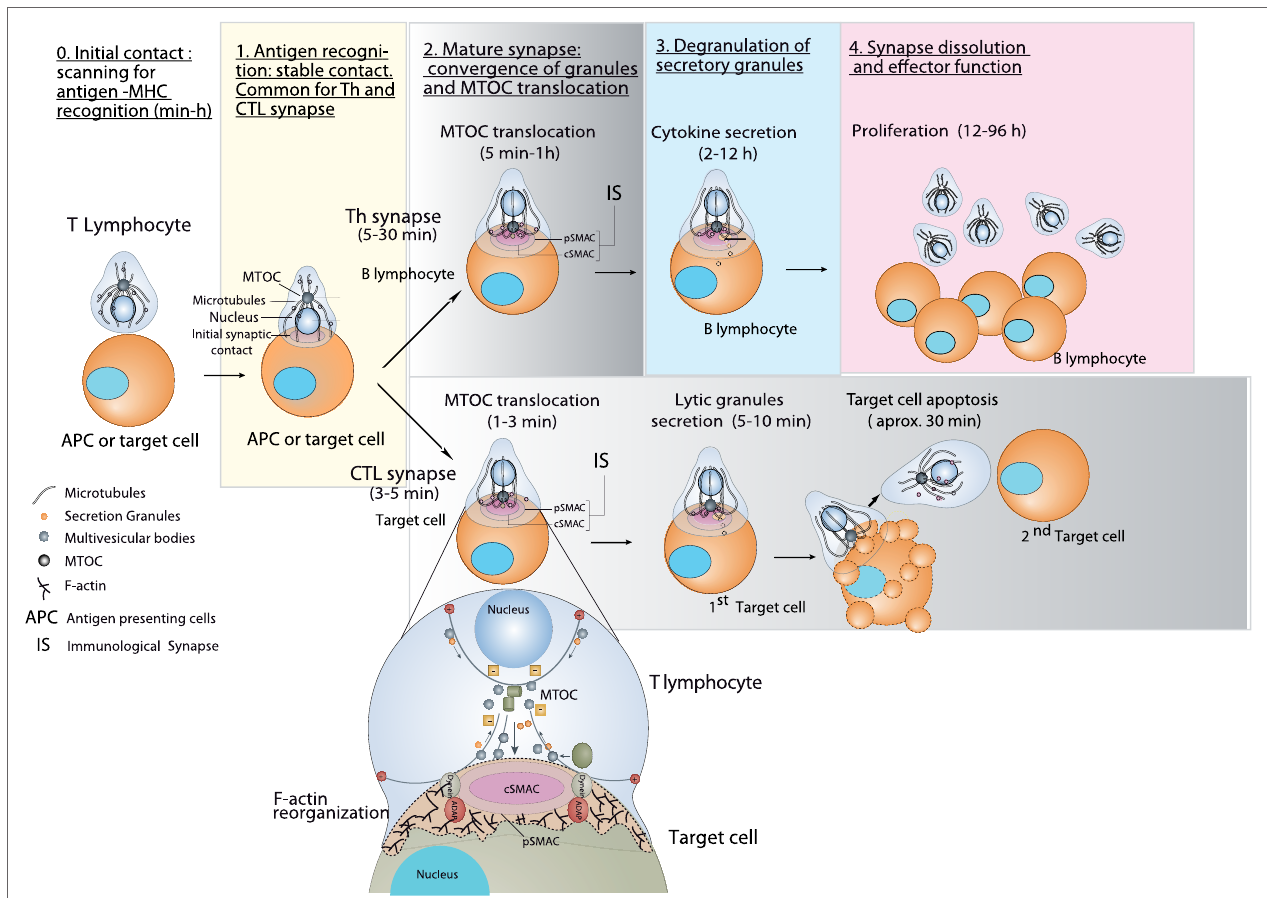
FigURe 1 | Stages of helper T (Th) and cytotoxic synapses and polarized secretion toward the IS. Stages 0 and 1 are common for both Th and cytotoxic T lymphocyte (CTL) synapses. After the initial scanning contact for specific antigen–major histocompatibility complex (MHC) complexes, Th effector T lymphocytes (upper chain of events) form mature synapses with antigen-presenting B lymphocytes within several minutes. This IS lasts many hours during which de novo cytokine (i.e., IL-2, IFN- γ ) production (involving de novo gene transcription) and secretion occurs, that requires continuous T cell receptor (TCR) signaling. After IS formation, Th lymphocytes may also undergo non-polarized (multidirectional) secretory traffic of certain cytokines (TNF- α , IL-4) (13). This fact has not been depicted for clarity reasons. The cell conjugates split after several hours, and then the lymphocytes eventually proliferate. Primed effector CTLs (lower chain of events) establish more transient, mature synapses after scanning their target cells (i.e., a cell infected with a virus), and deliver their lethal hits within a few minutes. Secretory lysosomes (lytic granules) are very rapidly transported (within very few minutes) toward the microtubule-organizing center (MTOC) (in the minus “ − ” direction) and, almost simultaneously, the MTOC polarizes toward the central supramolecular activation cluster (cSMAC) of the IS, a filamentous actin (F-actin)-depleted area that constitutes a secretory domain (14). Non-polarized, multidirectional exocytosis of lytic granules from naïve CTLs has been shown also to be induced by resting human B cells (12). This fact has not been depicted for clarity reasons. MTOC translocation to the IS appears to be dependent of dynein motors anchored to adhesion and degranulation promoting adapter protein (ADAP) at the peripheral supramolecular activation cluster (pSMAC), that pull MTOC in the minus direction (15, 16). In both types of synapses (lower zoom panel), the initial F-actin reorganization in the cell–cell contact area, followed by a decrease in F-actin at cSMAC and an accumulation at the pSMAC appears to be involved in granule secretion (17, 18). Multivesicular bodies (MVBs) are also secretion granules involved in the polarized secretion of exosomes at the IS upon their degranulation (19,